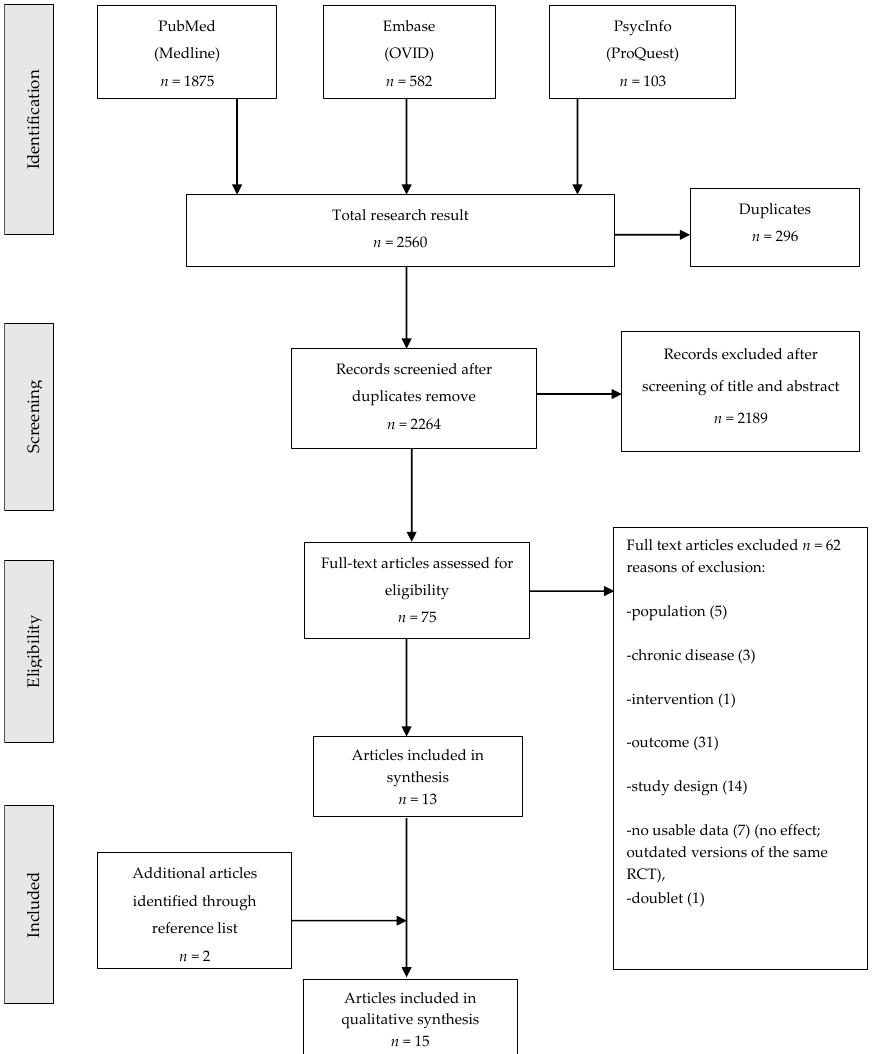
Figure 1. Flow diagram of study selection according to the Preferred Reporting Items for Systematic Reviews (PRISMA).